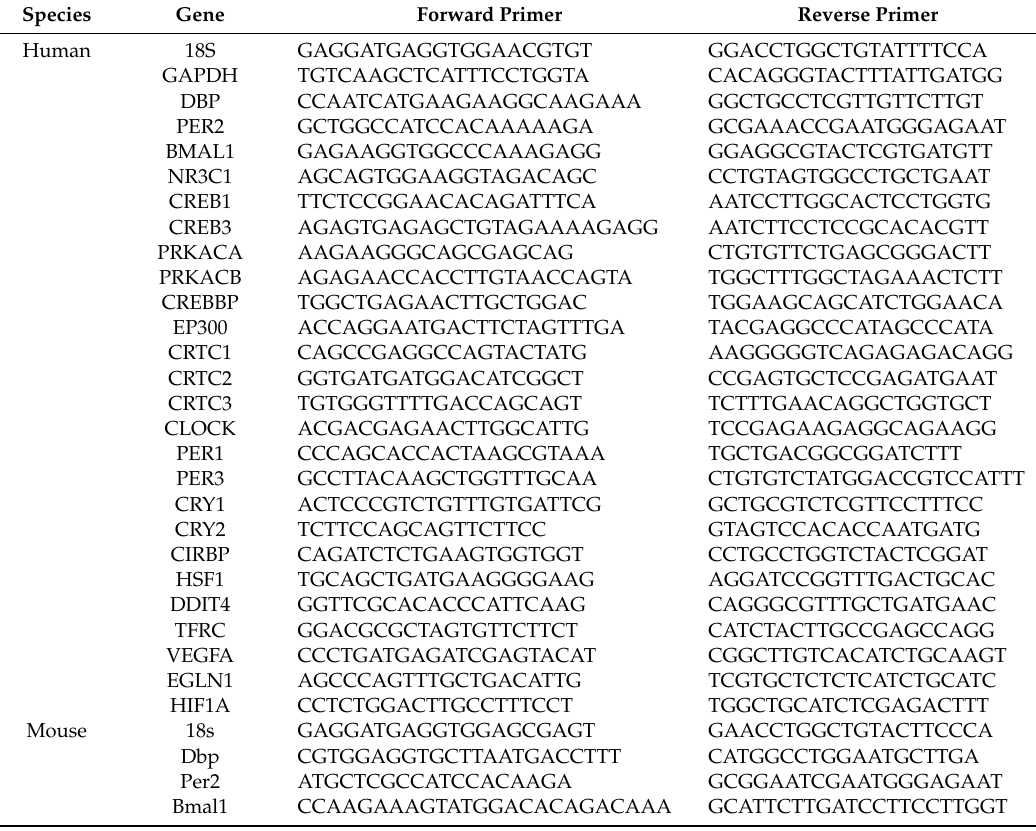
Table 1. Sequence of primers used for quantitative real-time